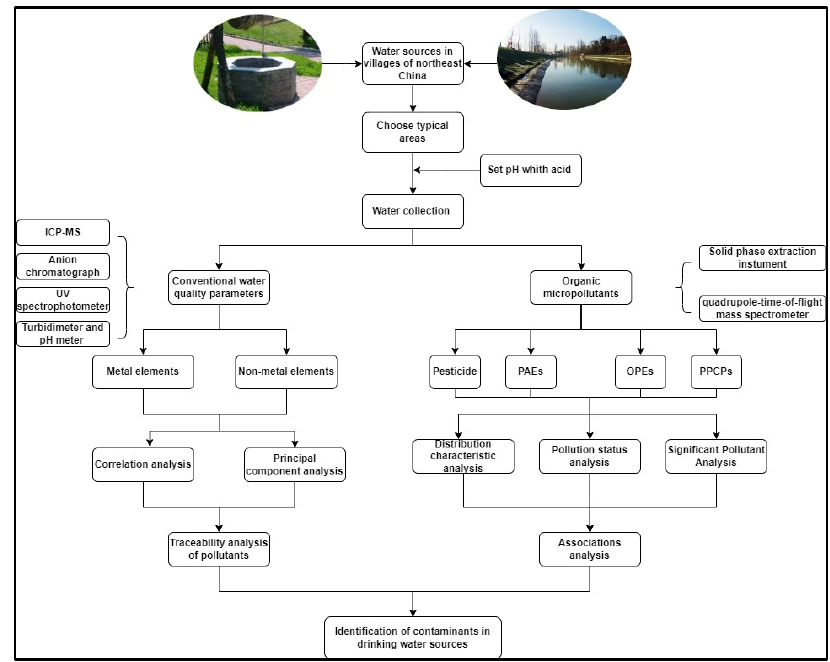
Figure 2. Flow chart of the whole experiment.